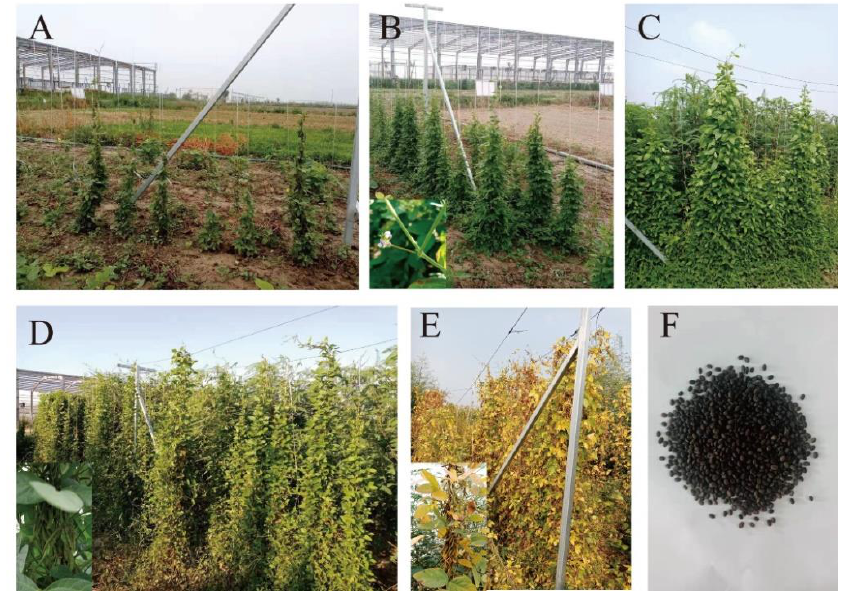
Figure 2. Growth status of wild soybean in different growth periods. A : Vegetative growth stage in the 50th; B : the first opened flower occurred in the 70th; C : boom stage in the 90th; D : the “wild